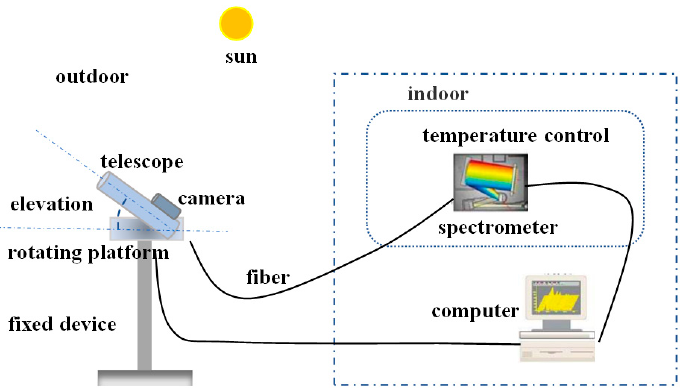
Figure 1. Measurement principle of the multi-axis differential optical absorption spectroscopy (MAX-DOAS) instrument. Table 1. Parameter settings for MAX-DOAS